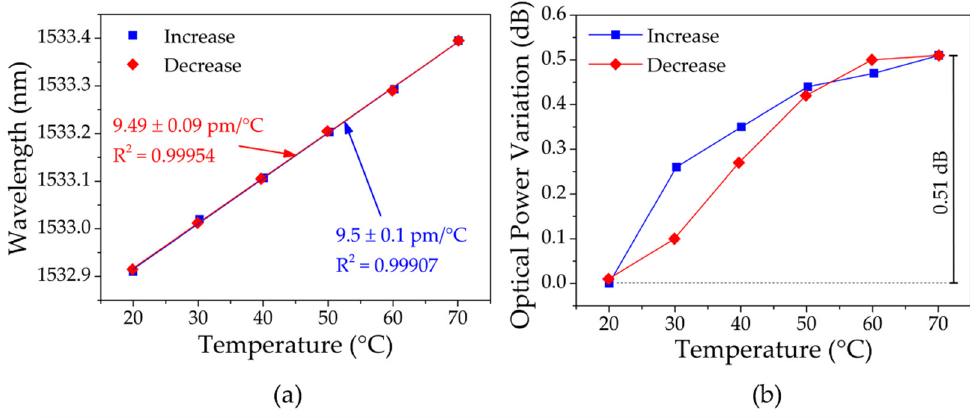
Figure 15. Resulting signal response from the silica gratings to the increasing/decreasing tempera- ture: ( a ) wavelength; ( b ) optical power variation.